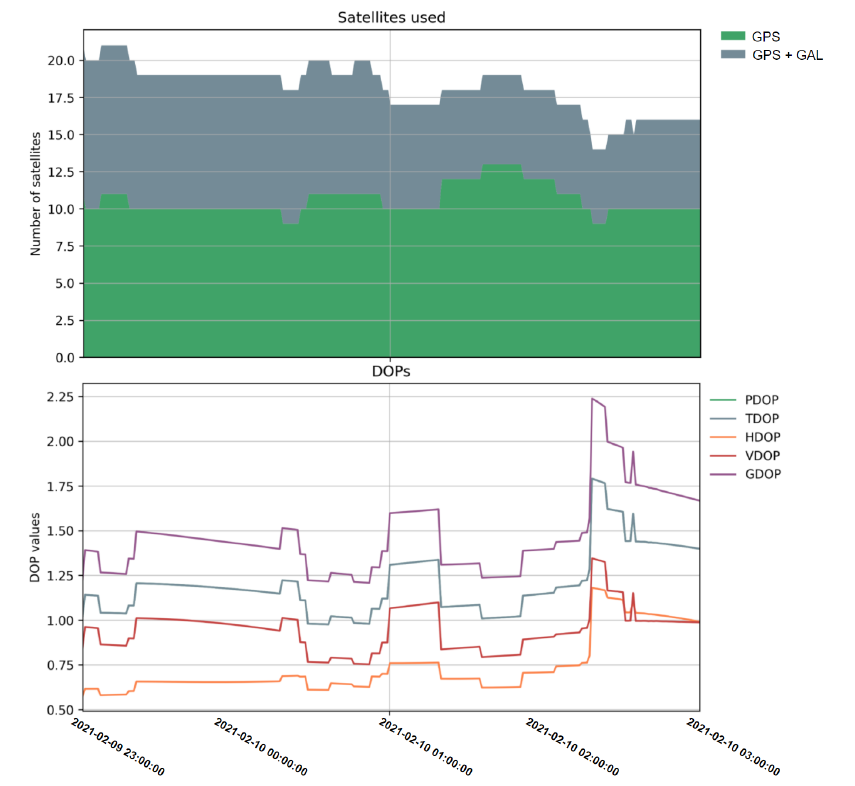
Figure 7. Number of satellites used ( top ) and the DOP values ( bottom ) of the collected snapshot